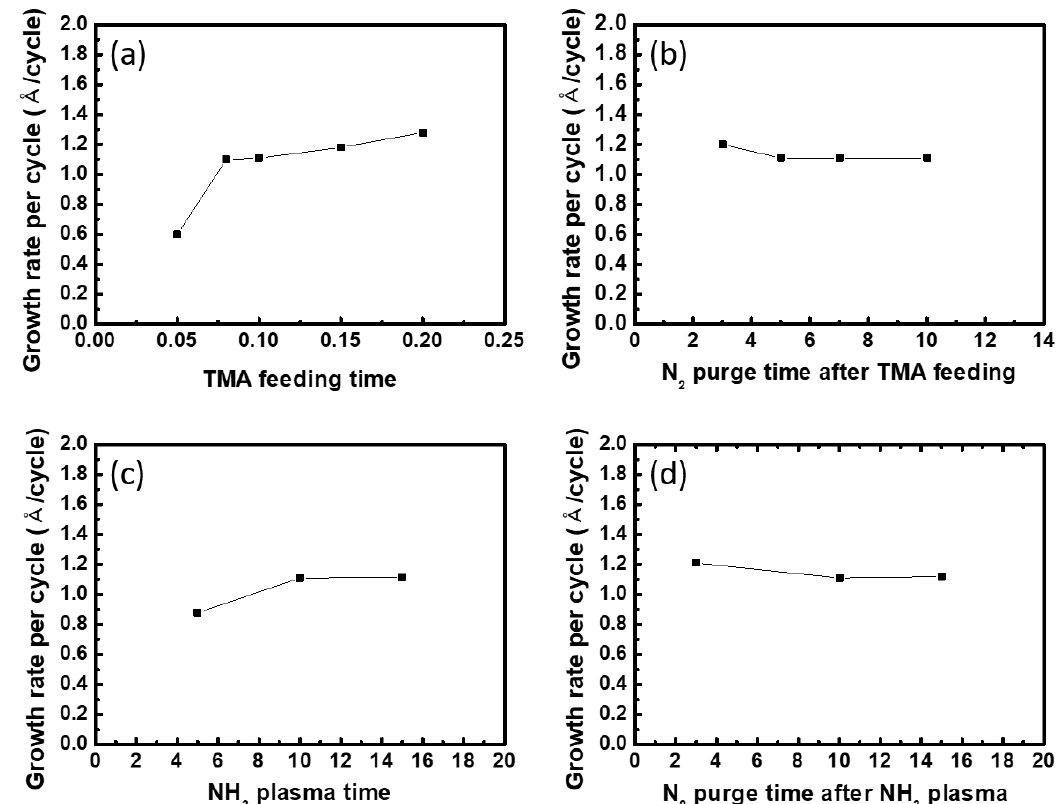
Figure 3. (a – d ) Growth rate per cycle (GPC) values for AlN deposited using the PEALD system as a function of the trimethylaluminum (TMA) feeding time, N 2 purge time after TMA feeding, NH 3 plasma time, and N 2 purge time after NH 3 plasma (NH 3 plasma power: 100 W).